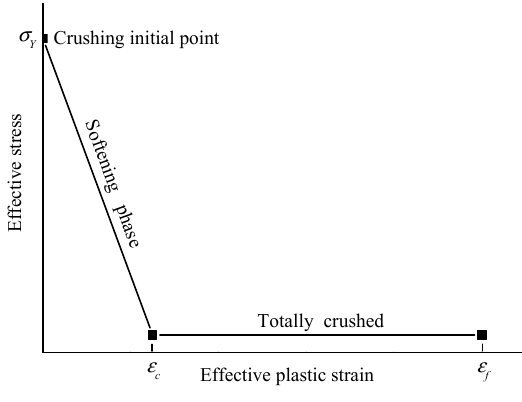
Figure 3. Elastoplastic constitutive law given.